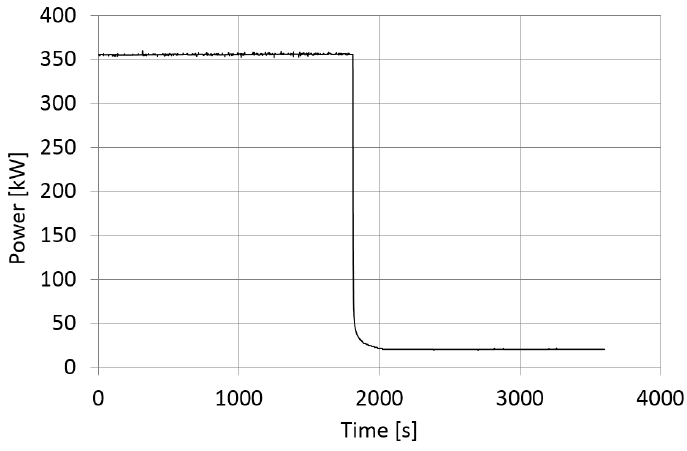
Figure 2. Fuel Pin Simulator (FPS) electrical power time trend.